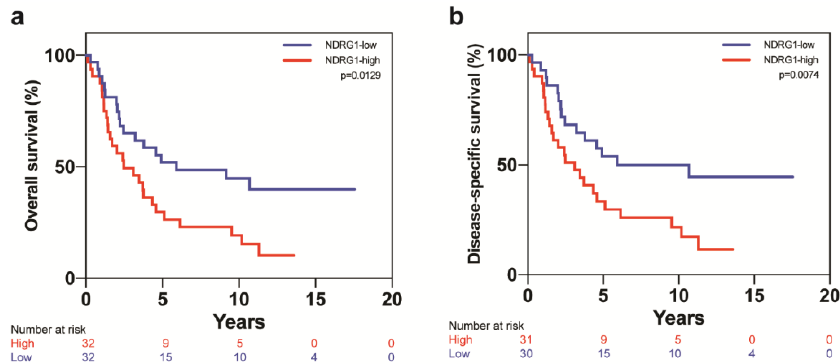
Figure 2. NDRG1 is a predictor of poor outcome in patients with IBC. Kaplan–Meier analysis showed